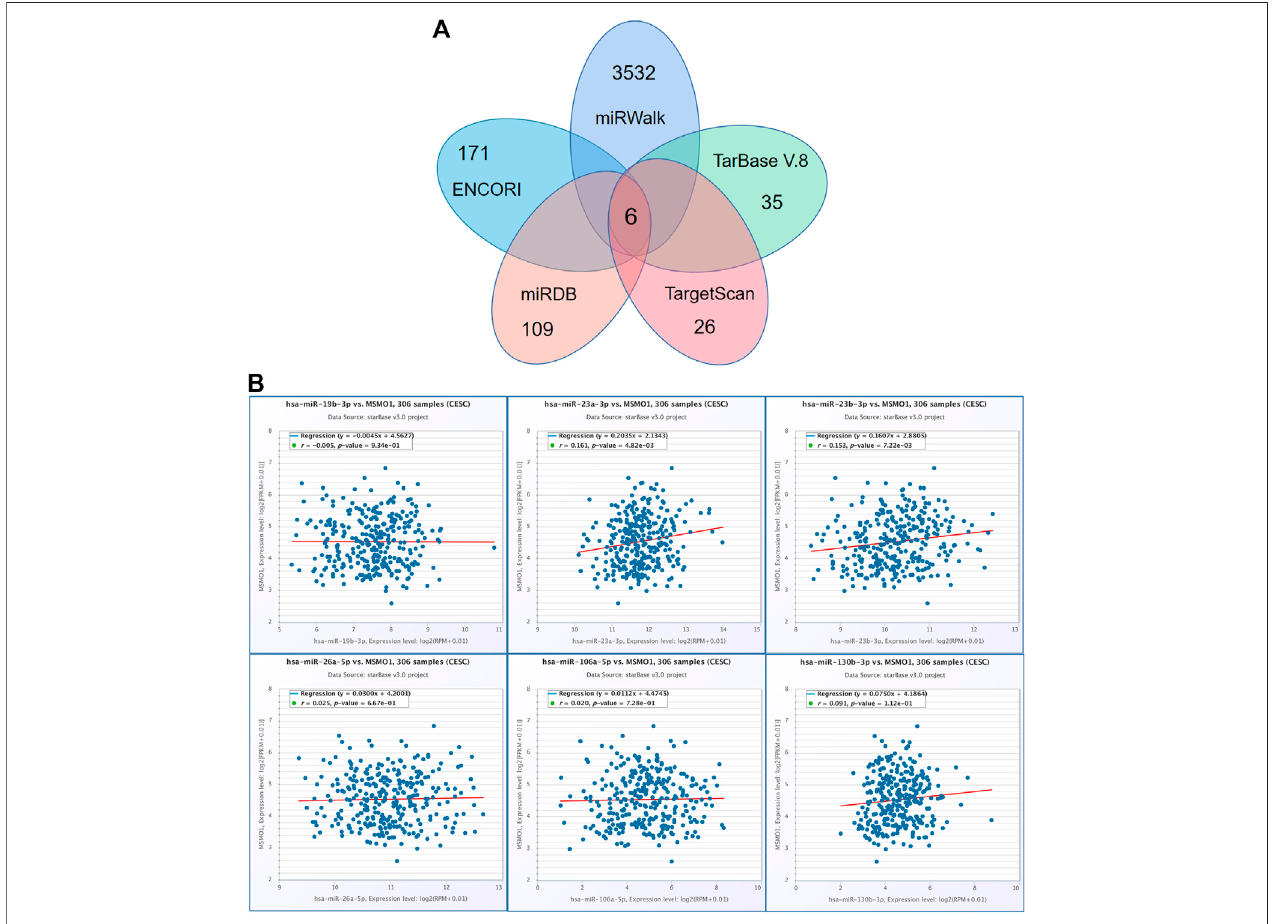
FIGURE 11 | The regulation of miRNA to MSMO1. (A) Obtain overlapping MSMO1 targeting miRNA from various prediction tools. (B) Using ENCORI tool, the correlation between MSMO1 and its miRNA in CESC.